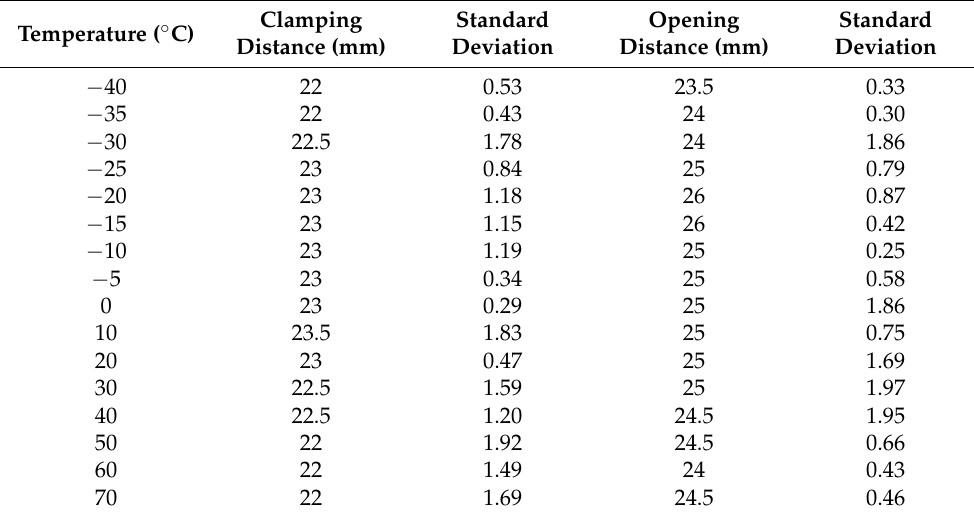
Table 2. MAS 333 magnetic contact on and off values during experimental tests. Clamping Temperature ( ◦ C) Distance